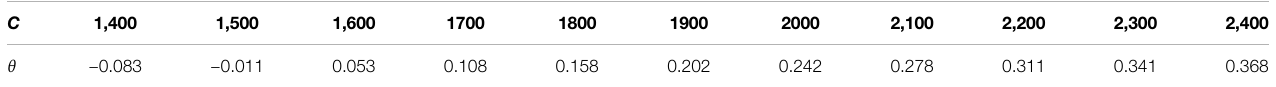
TABLE 5 | Bonus penalty strategy. Range of the difference